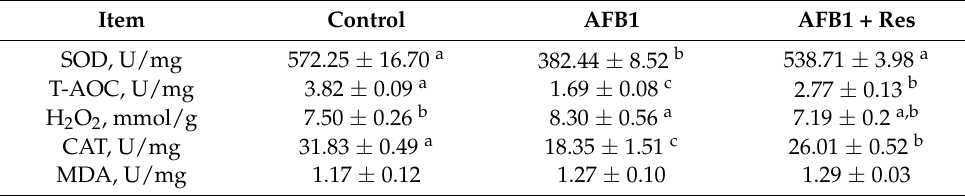
Table 4. Effects of Res on the antioxidative levels of duck liver exposed to AFB1.